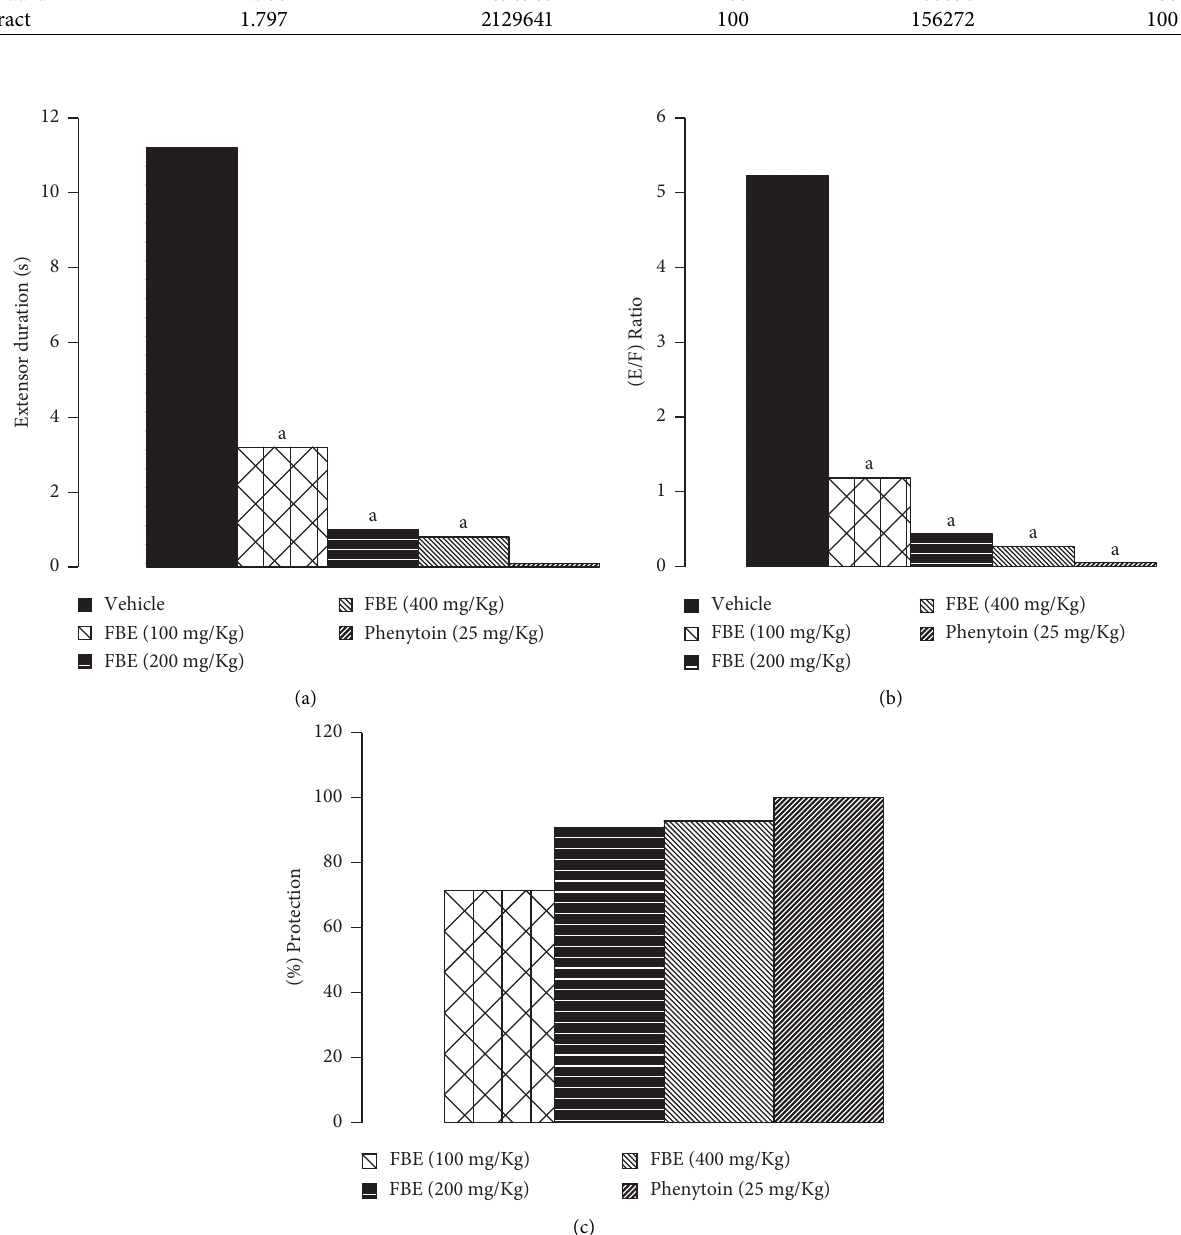
Figure 3: Efect of various pharmacological interventions on maximal electroshock-induced seizures. (a) Duration of the extensor, (b) extensor/fexor ratio, and (c) % protection. All values are expressed as the mean ± SEM. a p < 0 . 001 compared to the vehicle control. Te efect of various pharmacological interventions on picrotoxin-induced